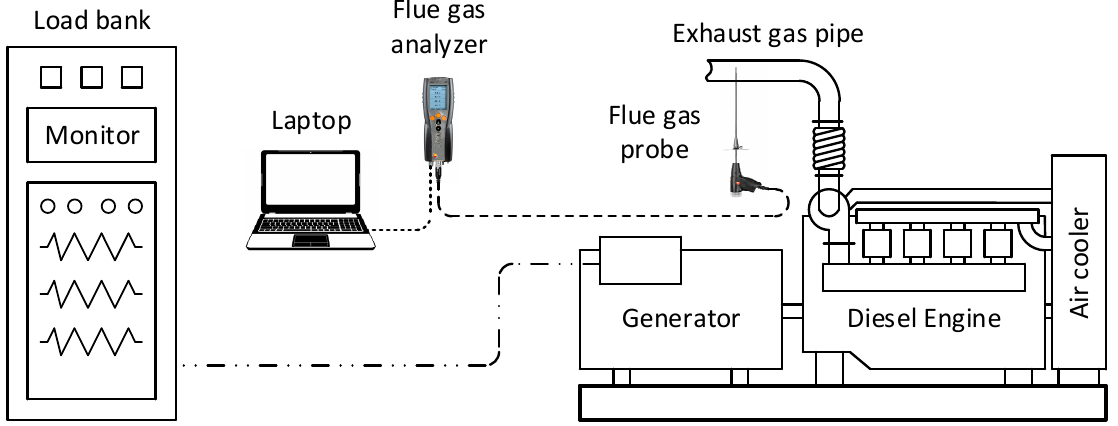
Figure 5. Schematic diagram of the experiment. Table 3. Specifications of the simulated engine.